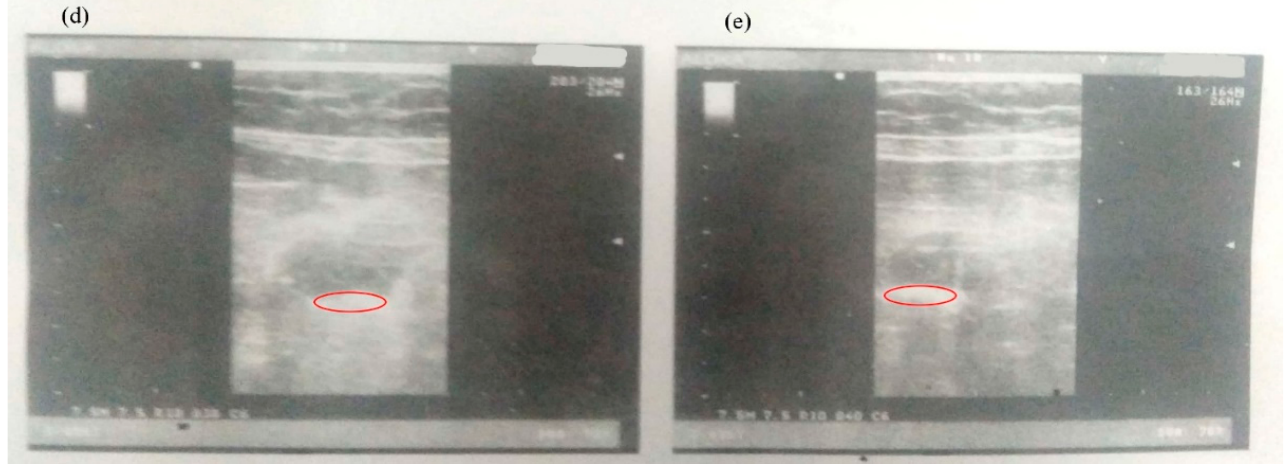
Figure 7. Ultrasound images for floating at ( a ) 0, ( b ) 3, ( c ) 6, ( d ) 9 and ( e ) 12 h.